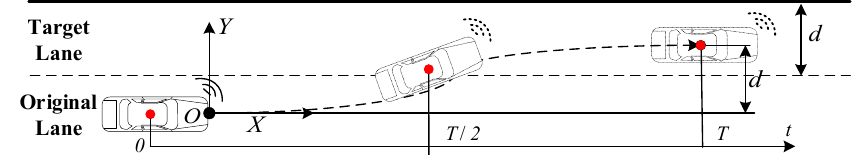
Figure 3. Lateral movement of lane change vehicle.